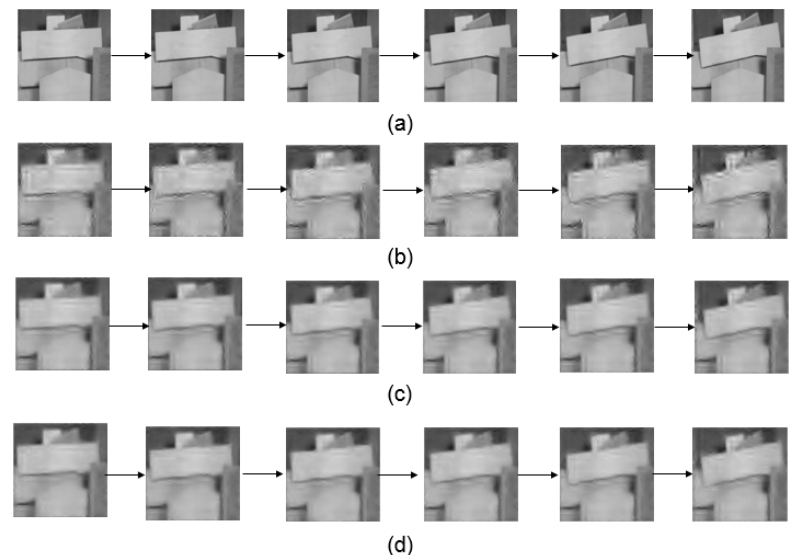
Figure 13. ( a ) The images from the second sample video; ( b ) The video recovered by traditional